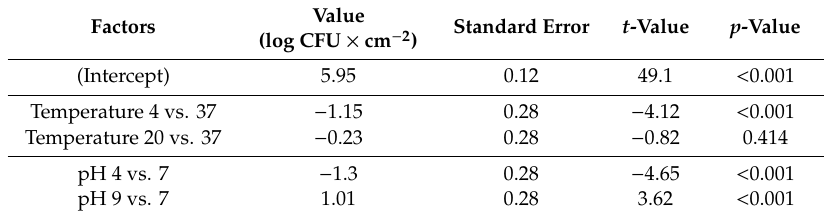
Table 3. Predictive factors for bacteria number in biofilm identified by linear